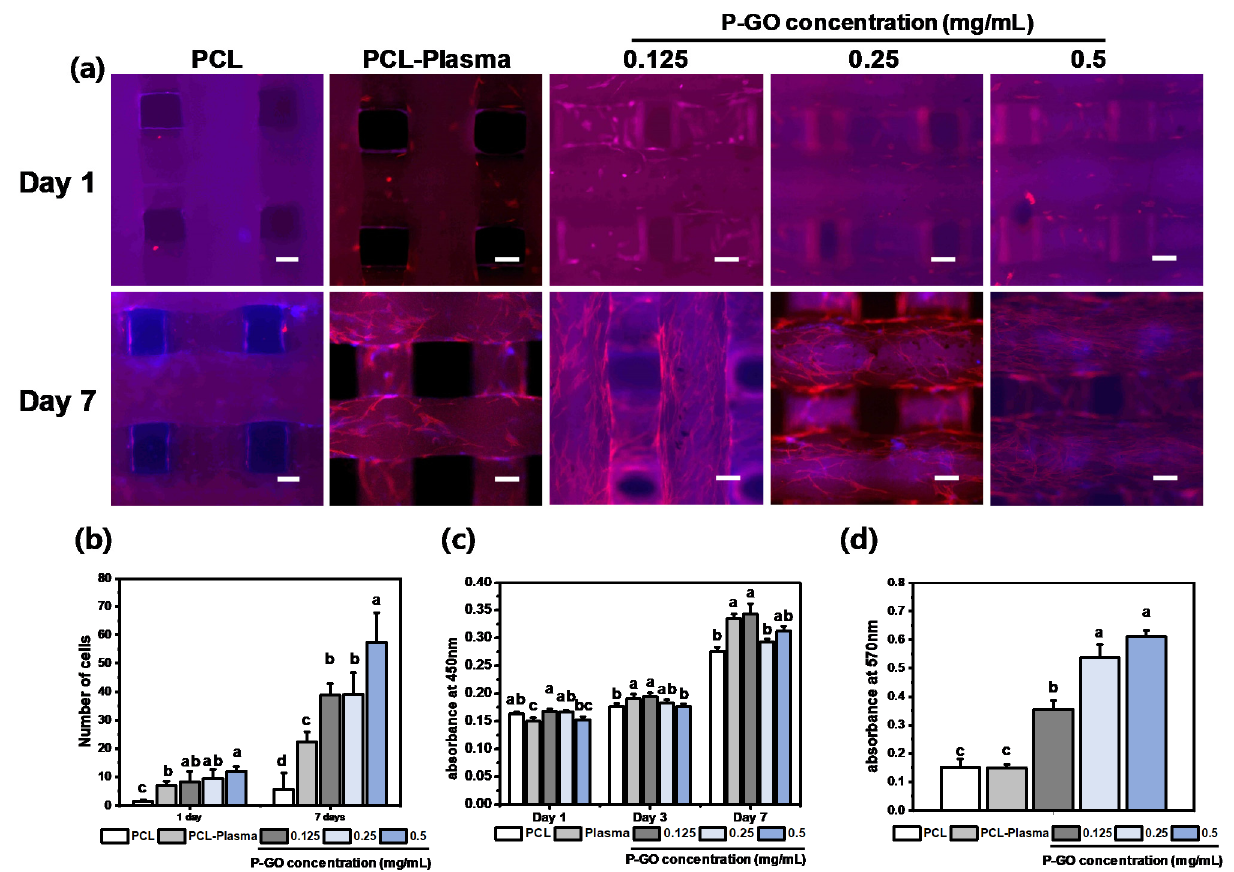
Figure 5. Cell viability on the scaffolds ( a ) Immunocytochemistry images of the scaffolds. Cytoskeleton was stained by tetramethylrhodamine (TRITC)-conjugated phalloidin (red). Cell nuclei were thus visualized by 4,6-diamidino-2-phenylinodole (DAPI, blue). Scale bars; 250 μ m. ( b ) Cell counting in immunocytochemistry image (ANOVA, Duncan’s multiple range test, p < 0.05). Same letters indicate that there is no significant difference between samples. ( c ) Cell viability results for the periodontal ligament stem cells (PDLSCs) on the PCL, PCL-plasma, and PCL-plasma-GO at 0.125 mg/mL, the PCL-plasma-GO at 0.25 mg/mL, and the PCL-plasma-GO at 0.5 mg/mL. The cell viabilities of the PDLSCs were measured at an absorbance of 450 nm. ( d ) Comparison of bovine serum albumin (BSA) protein absorption of the PCL, PCL-plasma, and with GO scaffolds after incubation for 24 h. The BSA protein absorption was measured at an absorbance of 570 nm (error bars indicate standard deviations, n = 5). (ANOVA, Duncan’s multiple range test, p < 0.05). Same letters indicate that there is no significant difference between samples.